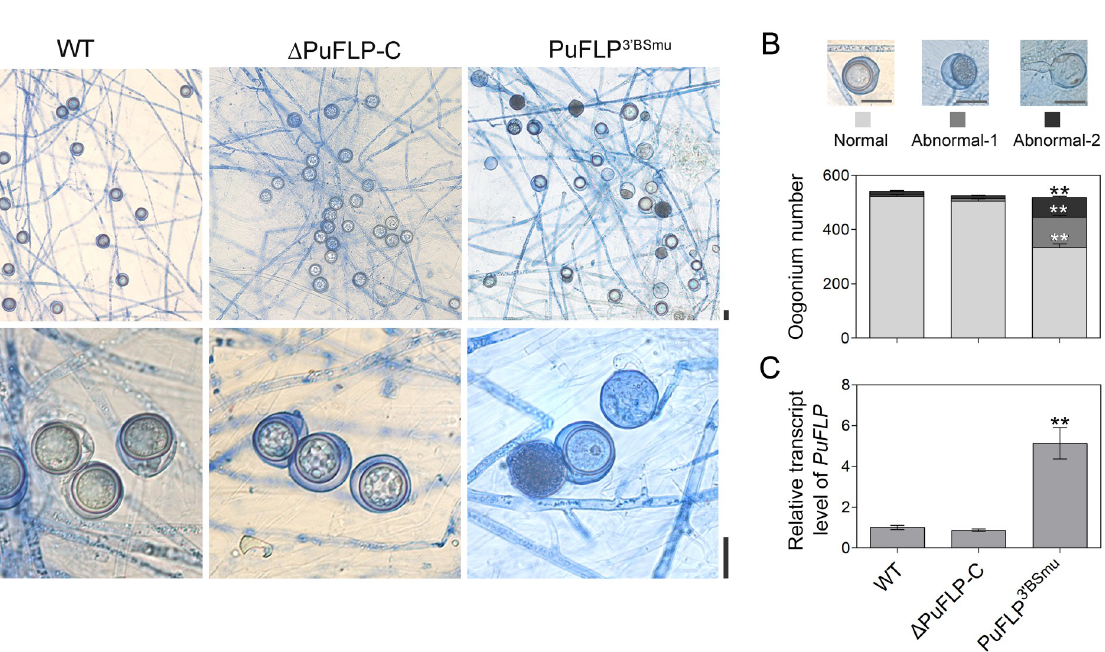
PLOS Pathogens| https://doi.org/10.1371/journal.ppat.1010001 October 14,